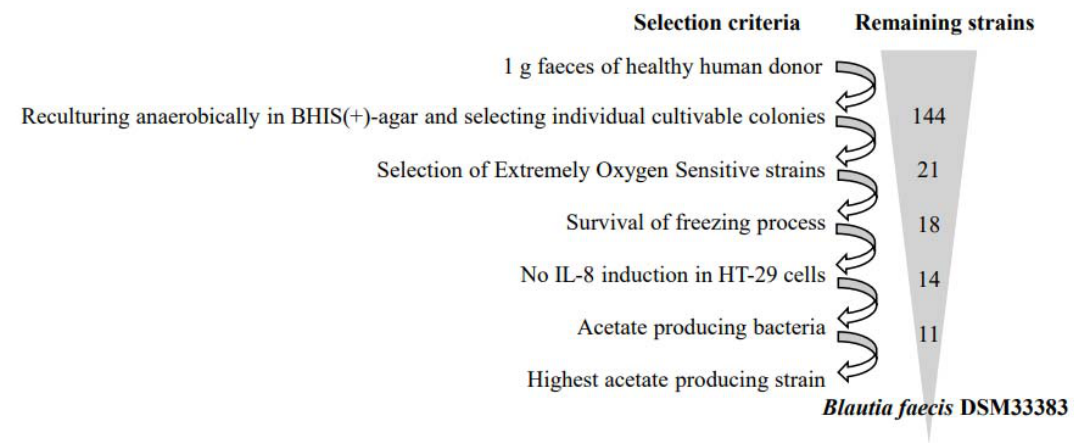
Figure 1. Overview of selection steps leading to the isolation of acetate-producing EOS strains.